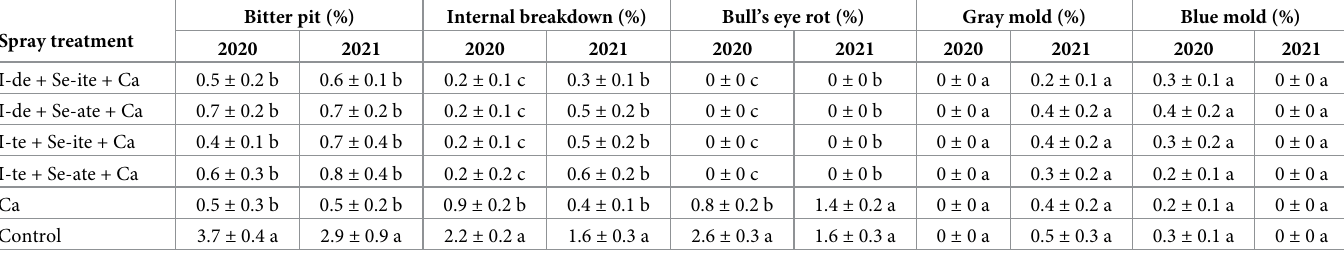
Means with the same letter within each column are not significantly different by Tukey’s multiple range test at α =